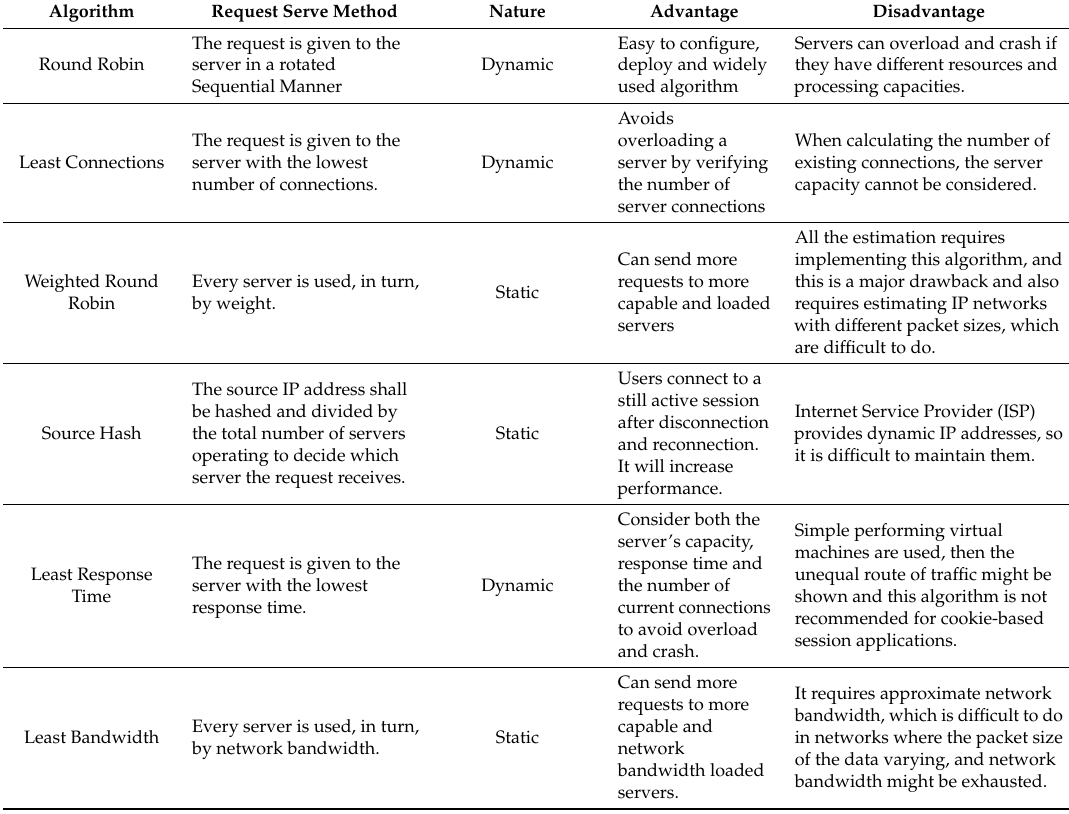
Table 1. The summarized features, advantage, disadvantage and di ff erences of the di ff erent load balancing